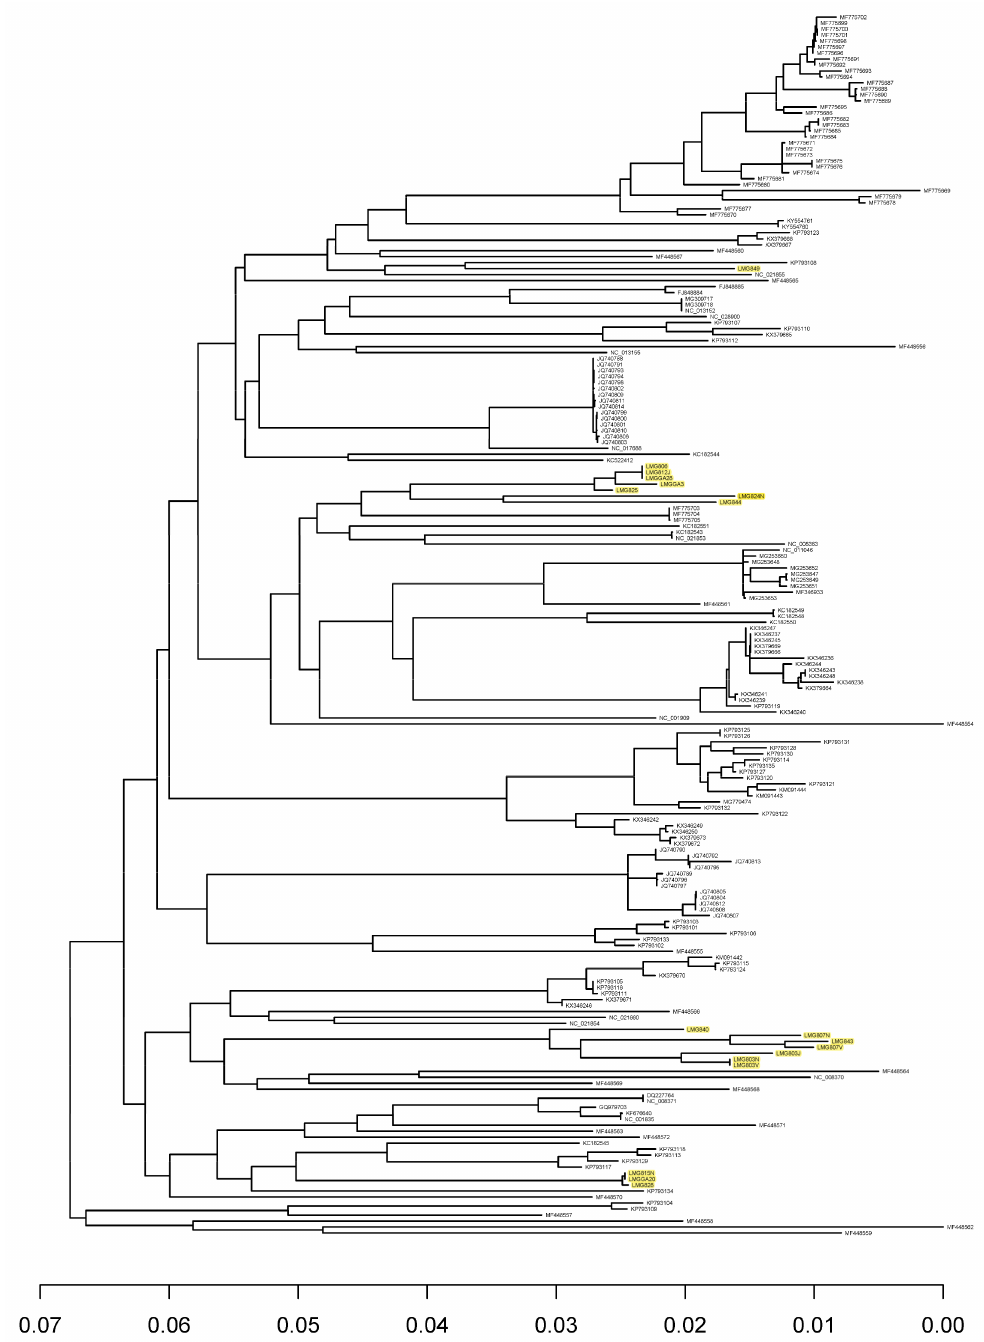
Figure 1. Phylogenetic tree of group 936 bacteriophages based on 29 core genes. Bacteriophages included in this study are given as “LMG” followed by three numbers. Bacteriophages acquired from the NCBI are presented by their accession numbers. Bacteriophages isolated in this work are